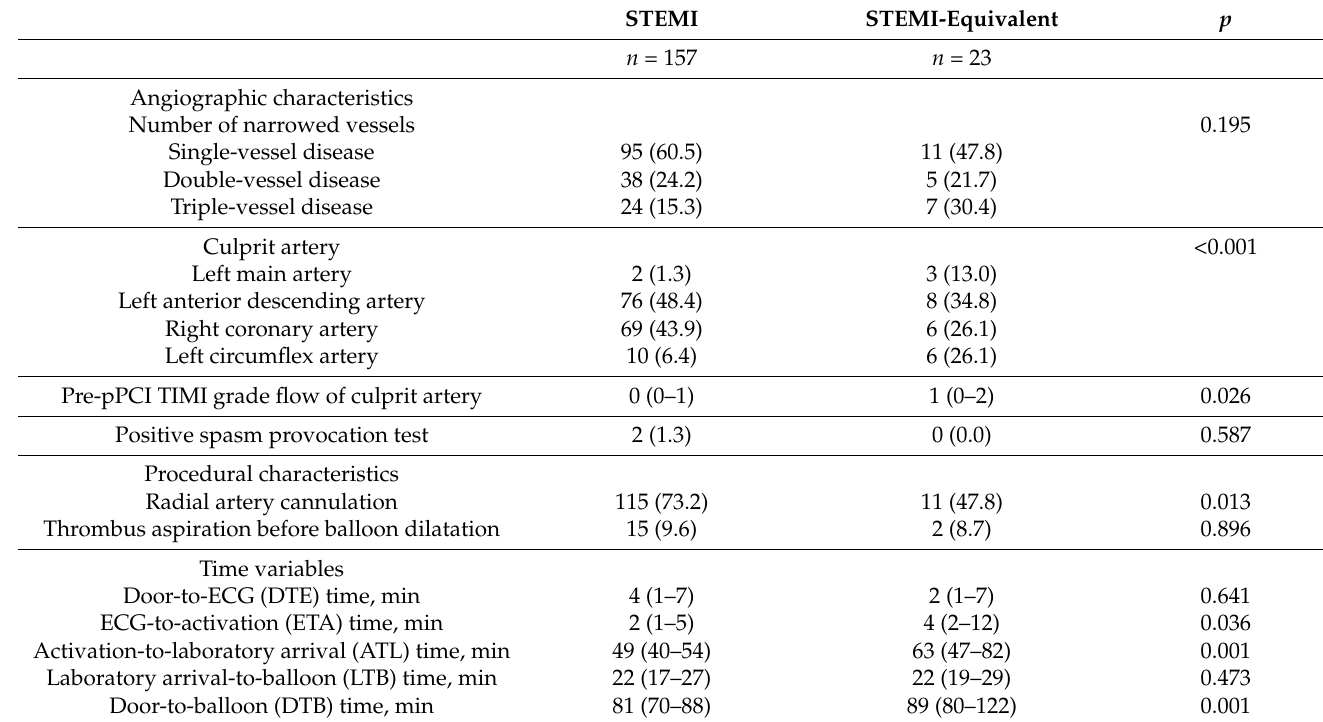
Table 3. Angiographic and procedural characteristics of patients presenting with STEMI or STEMI- equivalent